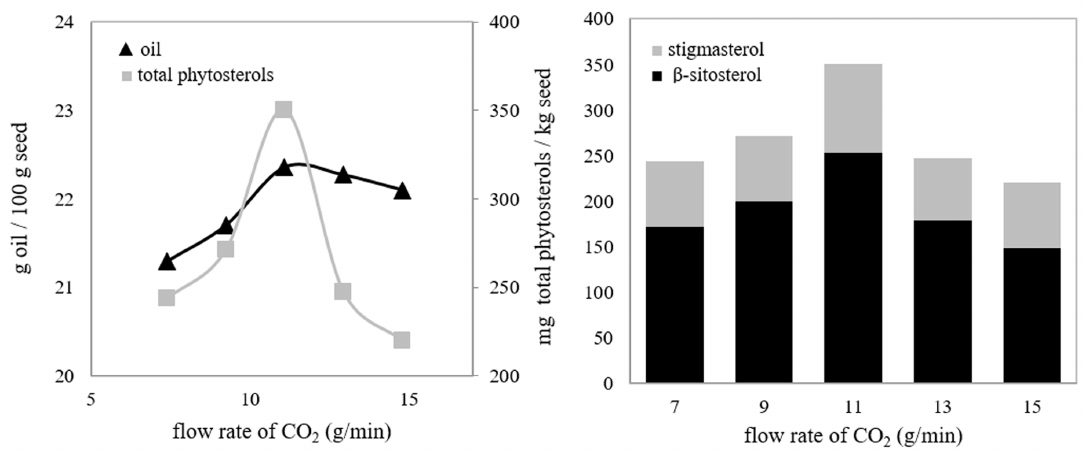
on the amounts of seed oil and phytosterols: 33°C, 200 bar, 0.8 mm mean particle size, 2 Figure 4: Effect of flow rate of SC-CO 2